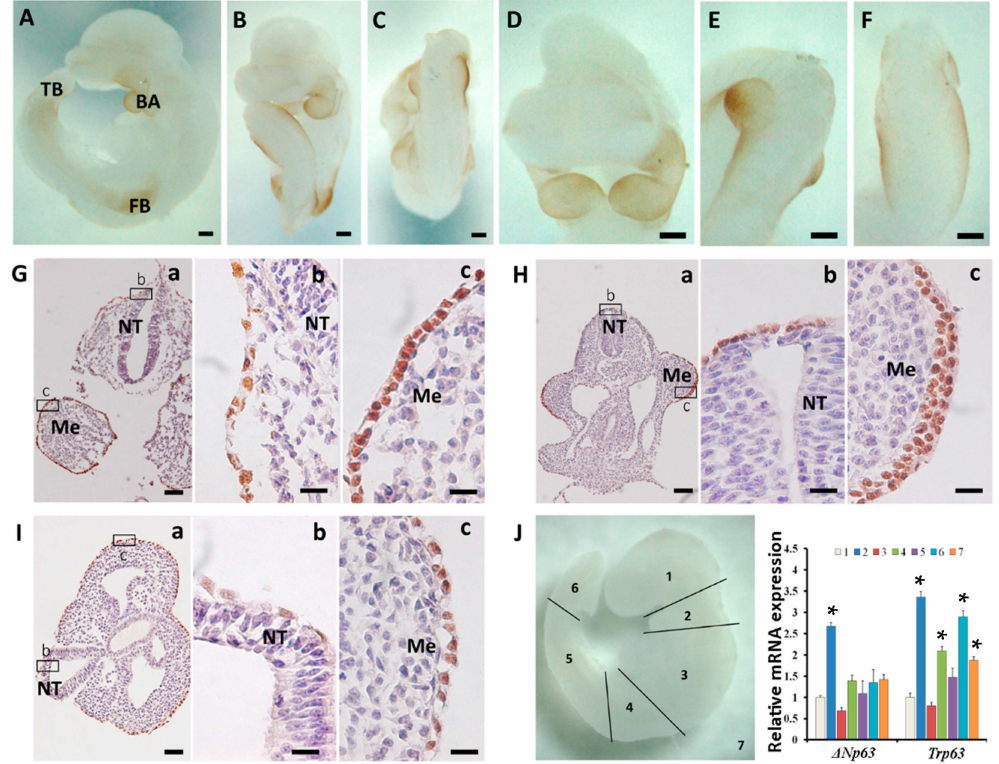
Figure 3. p63 expression in E9.5 embryos. ( A – C ) Different views showing the whole-mount immunostaining of p63 (( A ) lateral; ( B ) ventral; ( C ) dorsal view). ( D – F ) Images with higher magnification showing the head ( D ), forelimb buds ( E ) and the tail bud ( F ). ( G – I ) Transverse sections of the whole-mount stained E9.5 embryo. ( B , C ) show the boxed areas in ( A ), ( G ) head; ( H ) forelimb buds; ( I ) tail bud; ( J ) qRT-PCR results showing relative ∆ Np63 and Trp63 mRNA expression in different regions of the E9.5 embryo. Note that the numbers in the right panel of J are corresponded to the numbers in the left panel of J . BA, branchial arch; FB, forelimb bud; TB, tail bud; NT, neural tube; Me, mesenchyme. Bar = 200 µ m for ( A – F ); bar = 50 µ m for Ga , Ha and Ia ; bar = 20 µ m for Gb , c , Hb , c and Ib , c . * p < 0.05 when compared with